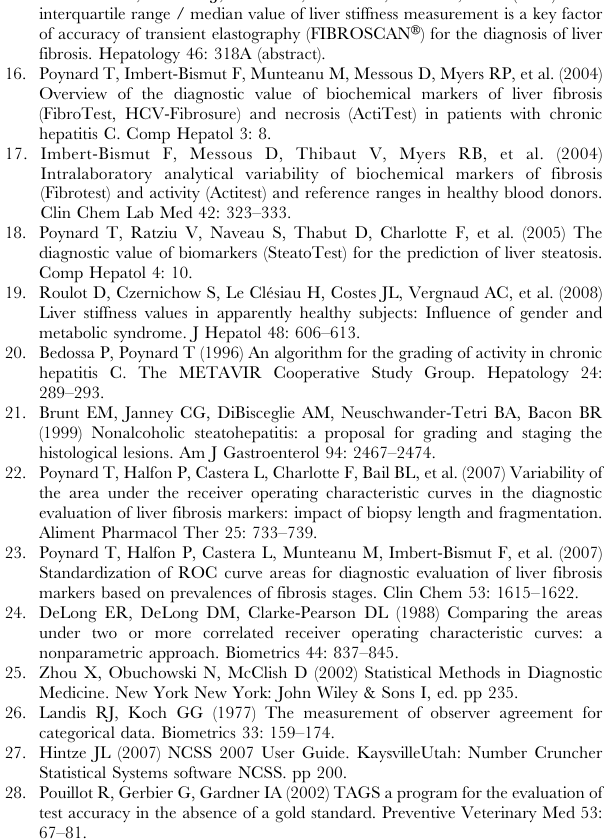
Table S4 Recommendations biopsy